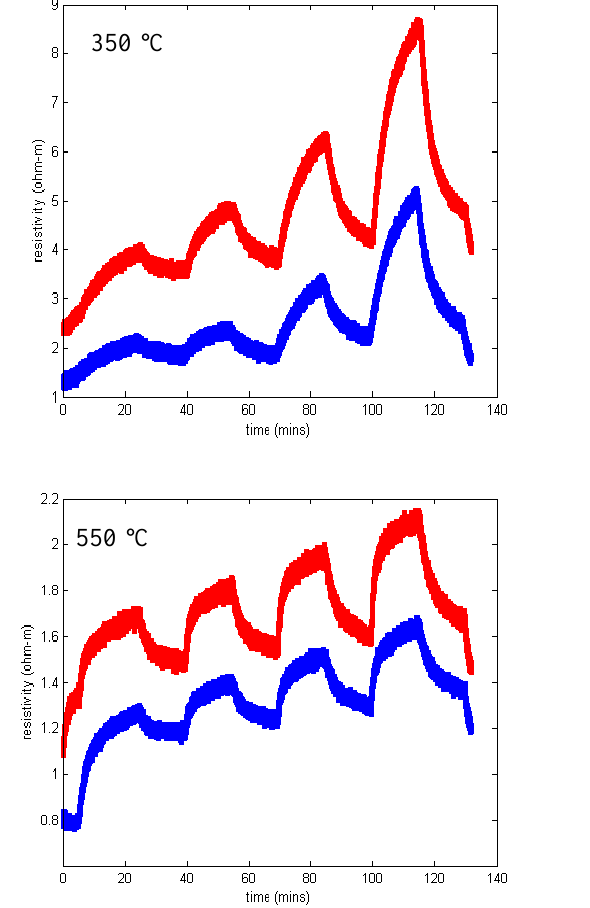
Figure 14. Resistivity measurements of 100 nm SnO to 650 °C. The blue trace is the first set of temperature measurements and red is the second set of measurements. Each plot shows the resistivity as a function of time when the oxygen concentration is varied according to Figure 11.